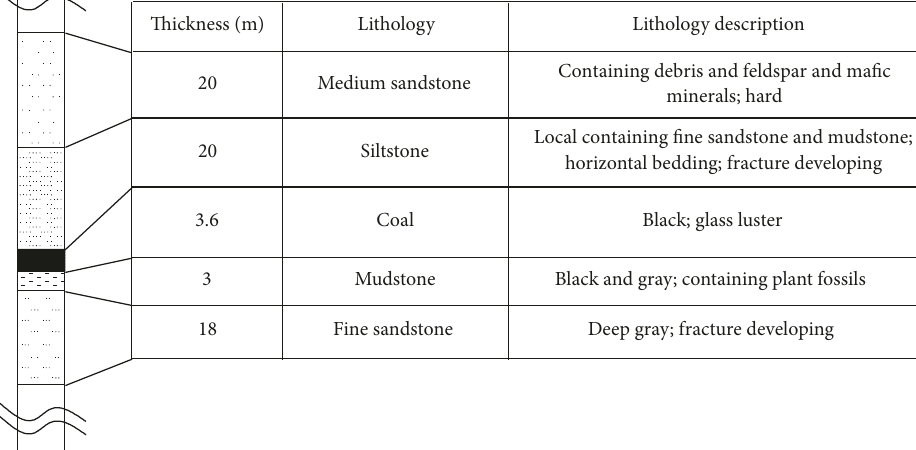
Figure 5: Strata geological log.